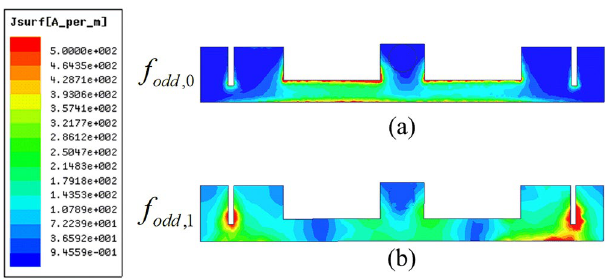
Figure 8. The surface current distribution of ( a ) fundamental odd mode and ( b ) 1st odd